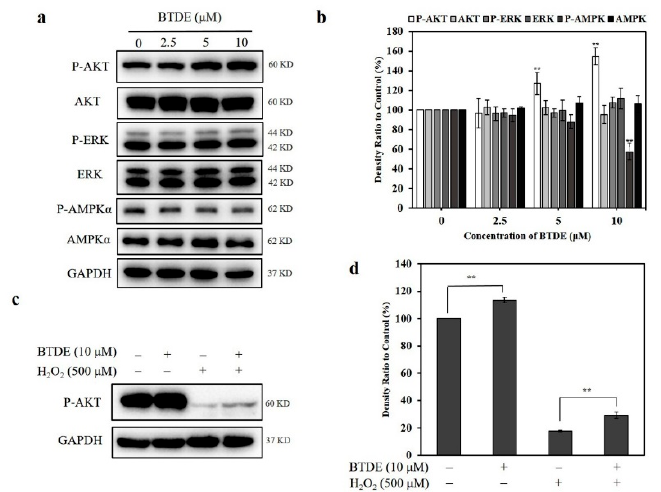
Figure 7. The effect of BTDE on the upstream signaling pathways of Nrf2. ( a , b ) HaCaT cells were treated with BTDE (2.5–10 µ M) for 24 h. The expression levels of the signaling molecules were detected by Western blotting assay. ( c , d ) HaCaT cells were pretreated with BTDE (2.5–10 µ M) for 24 h and then were incubated with or without H 2 O 2 (500 µ M) for 3 h. The expression level of P-AKT was detected by Western blotting assay. Values are expressed as the mean ± SD of three independent experiments. ** p < 0.01, versus control